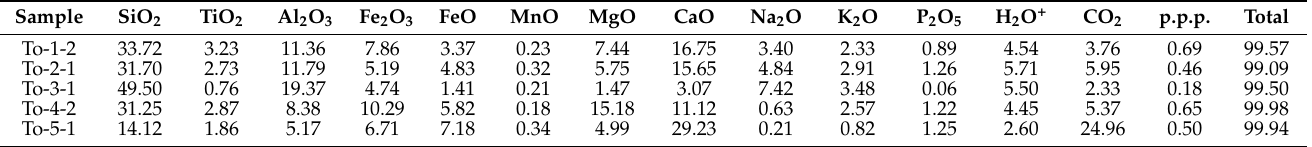
Table A1. Compositions of studied samples from rocks of Tomtor massif (all values in %).